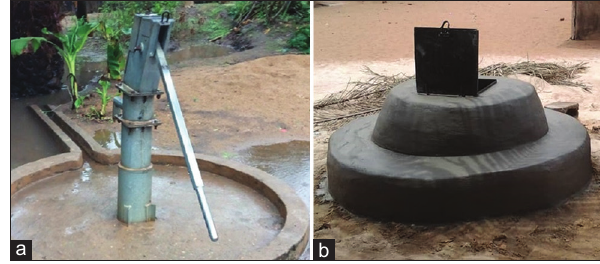
Figure-2: Some wells from which water samples were collected. (a) Borehole. (b) Concrete cased well.